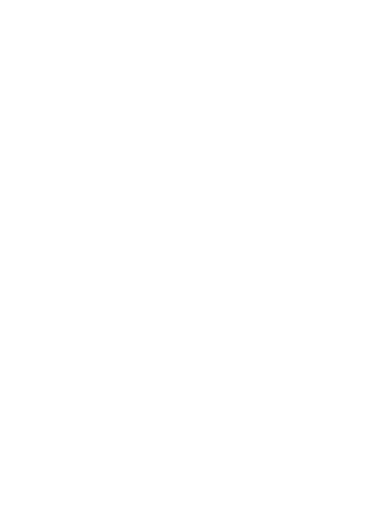
Figure 15. Progressive failure curve when the joint plane is α =